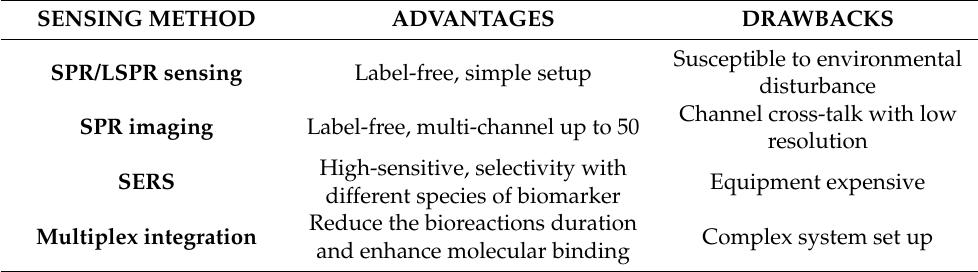
Table 1. The comparison of different sensing approaches of plasmonic biosensors in the microfluidic